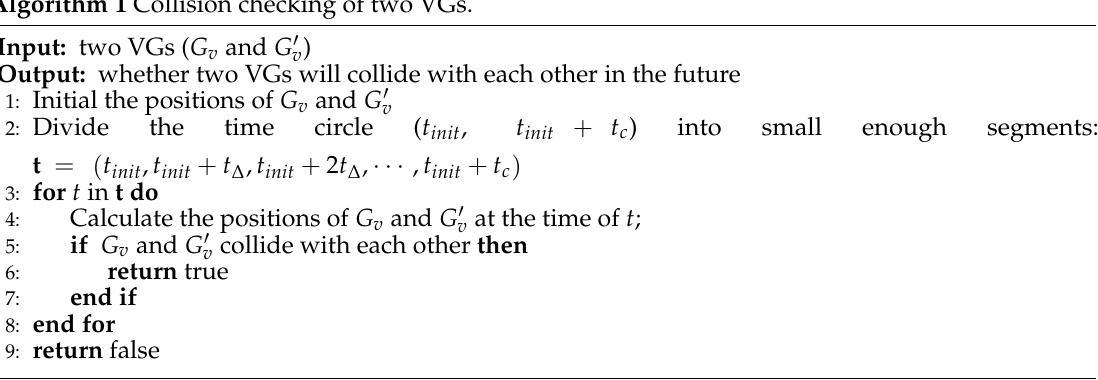
Algorithm 1 Collision checking of two